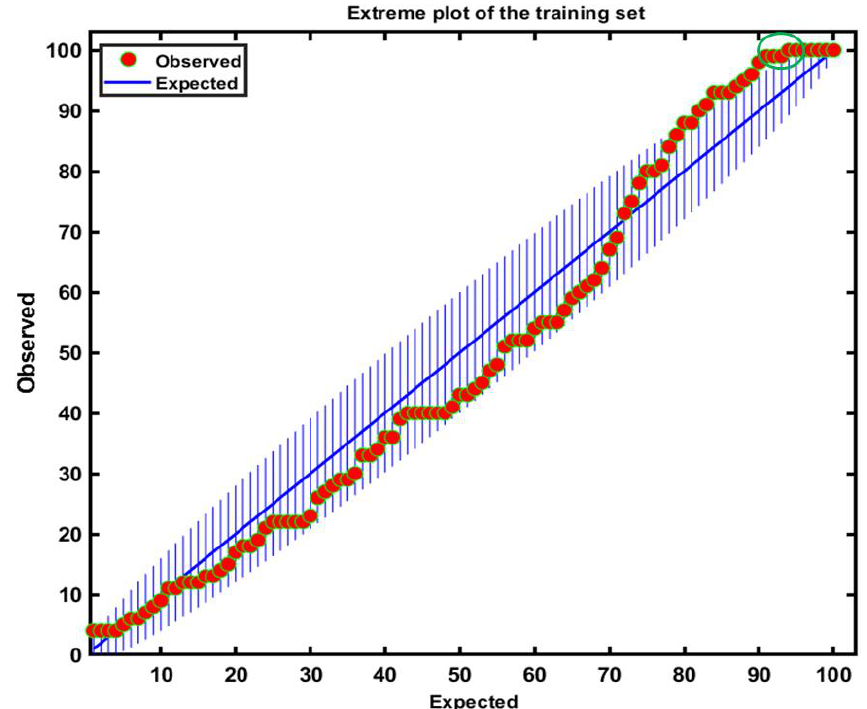
Figure 6. The extreme plot based on the developed model shows four samples deviating more significantly from the line (green circle).